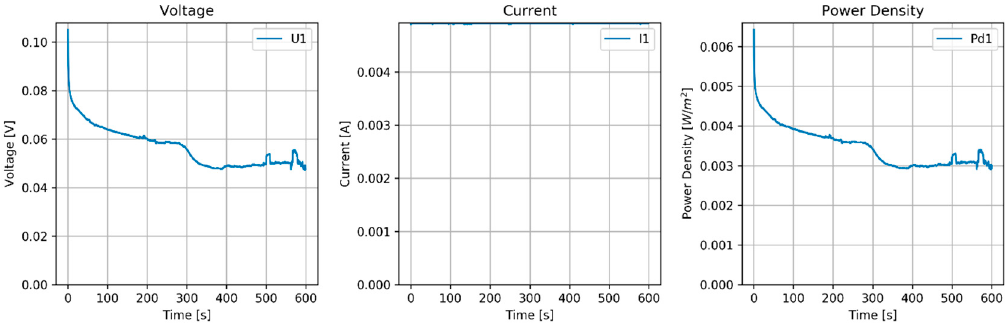
Figure 11. Results of MPPT test of the RED stack equipped with pseudo AEMs (Ag/AgCl) and pseudo CEMs (Zn). Flow rate (H and L) is 60 mL/min.